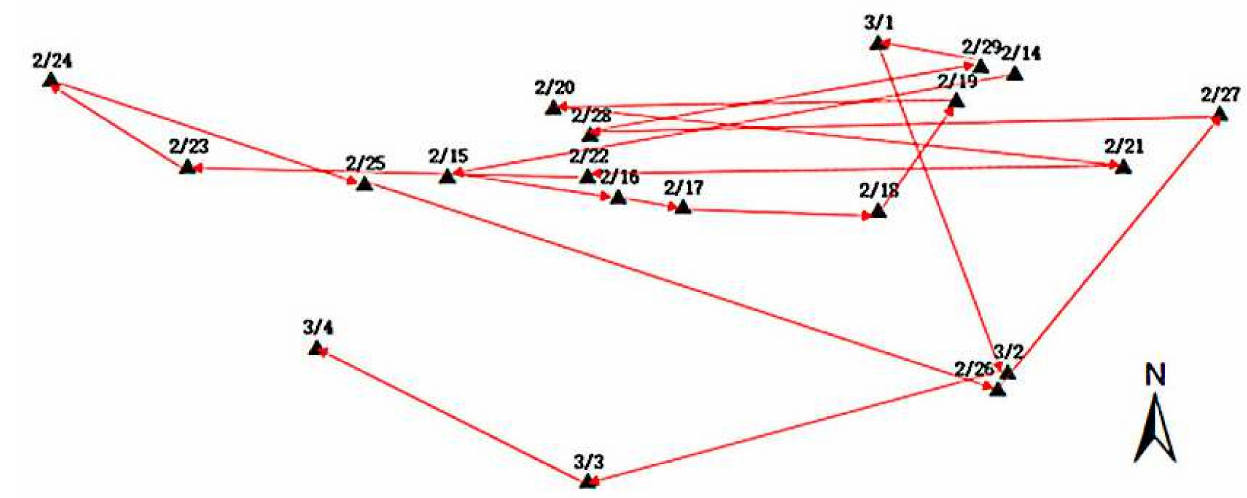
Figure 10. Changes in ice-shelf position.